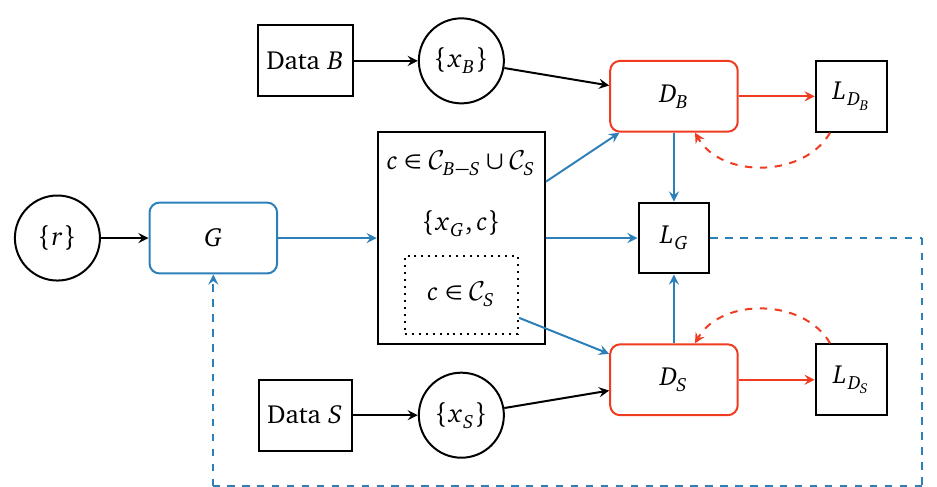
Figure 1: Structure of our subtraction GAN. The input { r } describes a batch of ran- } the true input data batches. The label c encodes the cate- dom numbers and { x B , S gory of the generated events. Blue arrows indicate the generator training, red arrows the discriminators